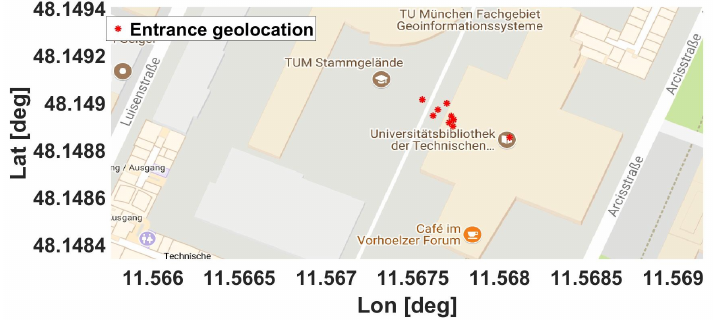
Figure 14. Locations that correspond to the detection of the outdoor–indoor transition